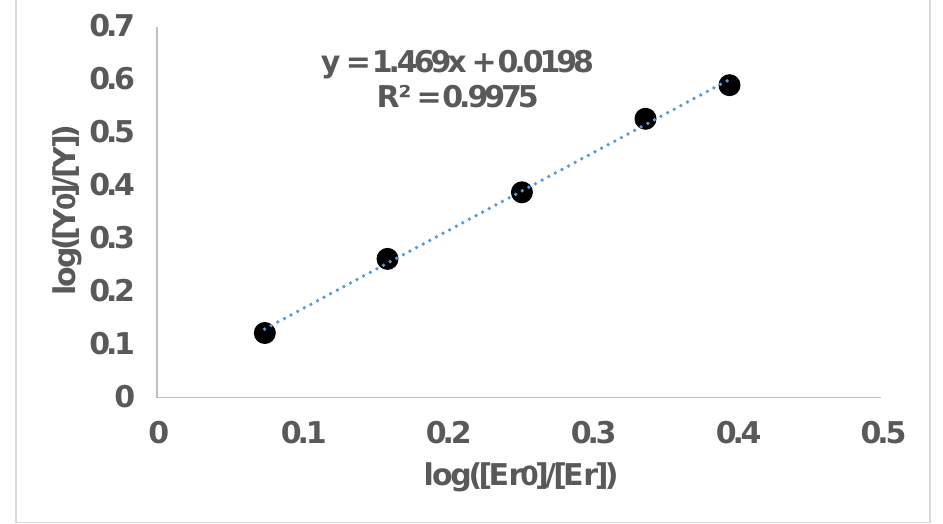
Figure 4. Enrichment of Y against Er: logarithm of the quotient of the starting concentration and final concentration for each rare earth.